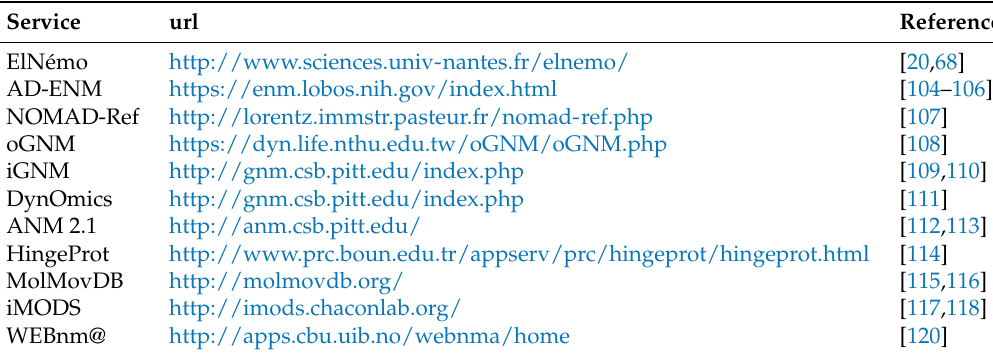
Table 1. The most commonly used NMA web